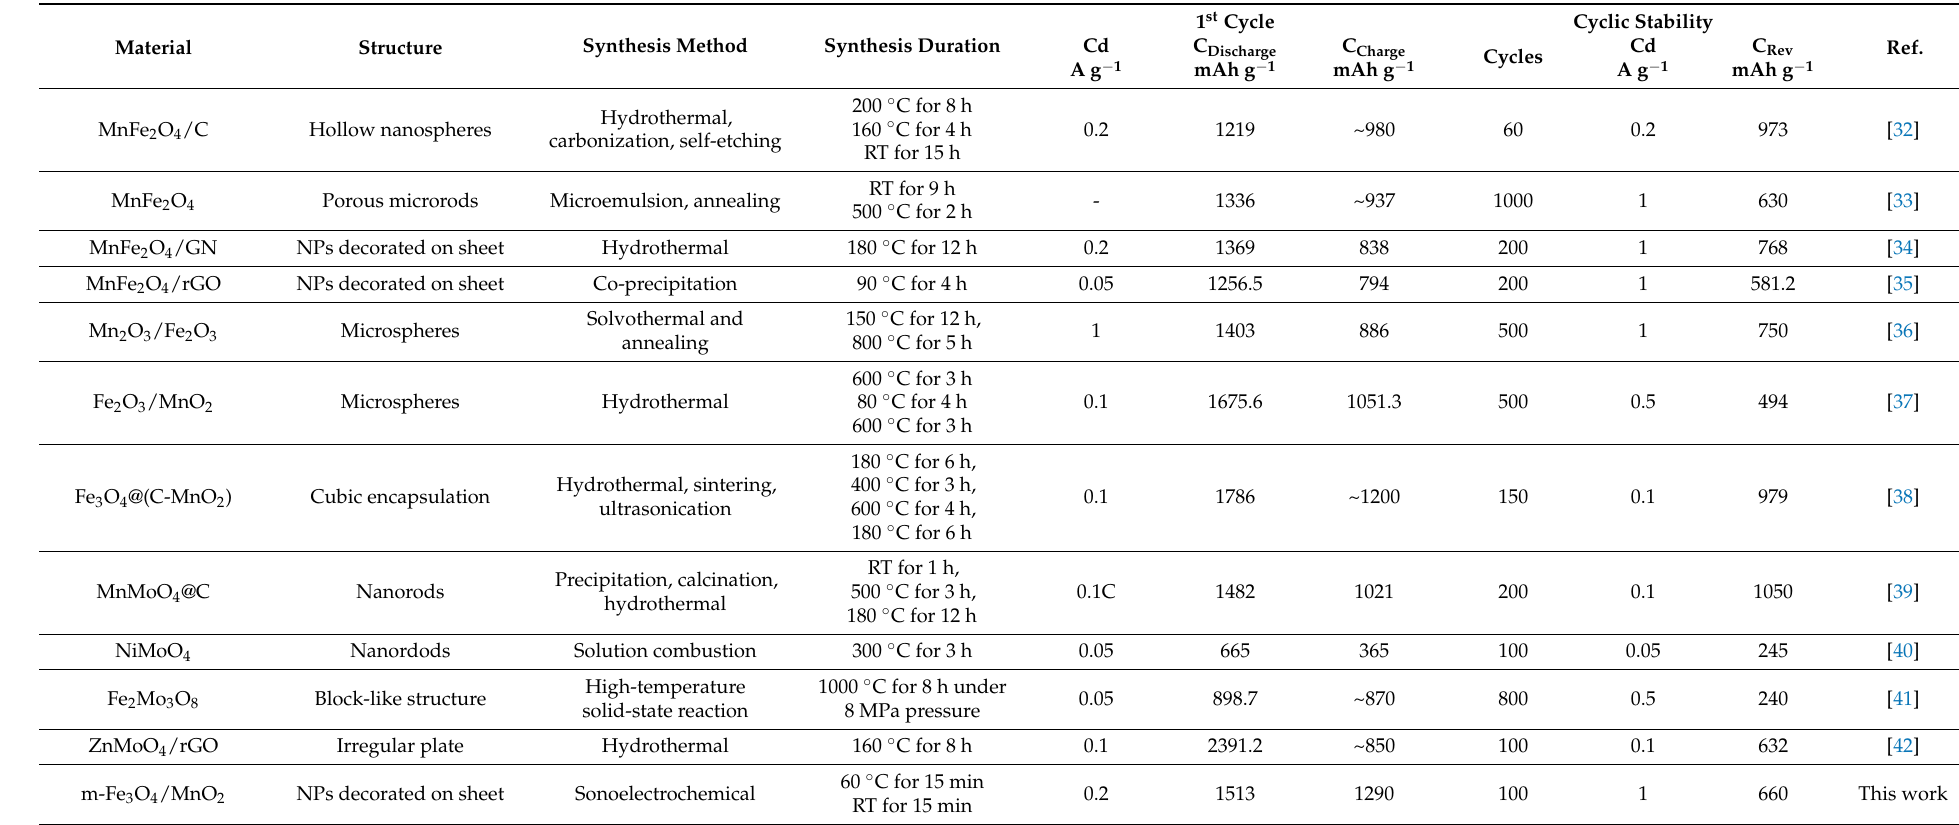
Table 2. Performance-comparison data of different recent anode materials for various energy